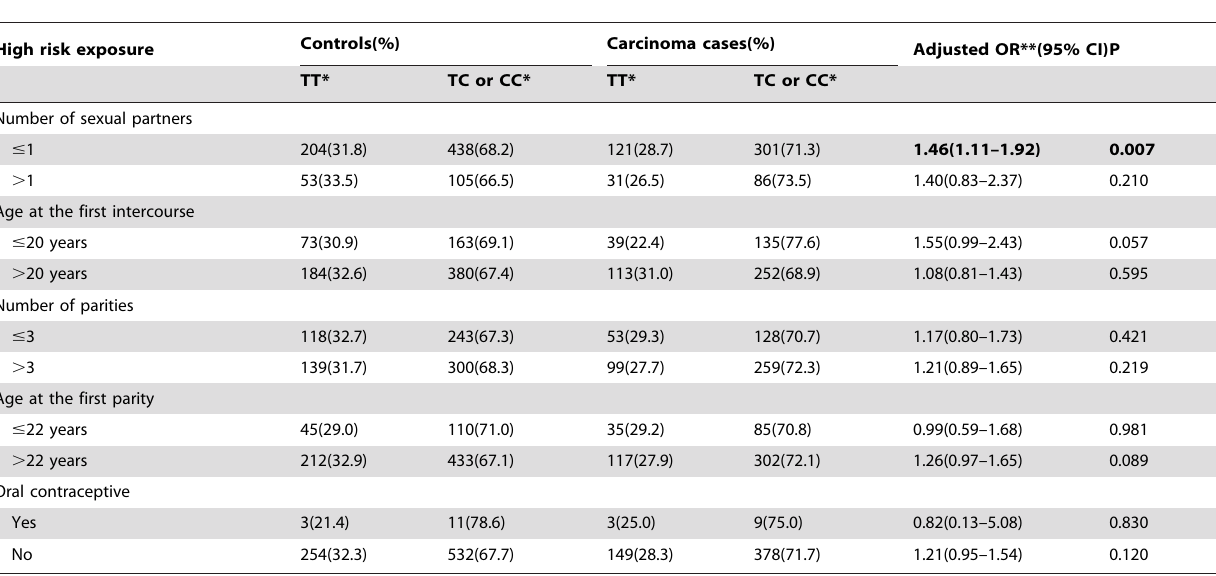
Table 6. According to different sexual or reproductive histories subgroup stratified analyses between the genotypes and cervical carcinoma